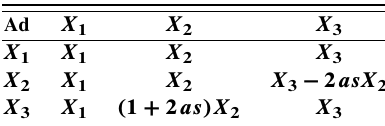
Table 3. Adjoint representation (BBM equation)